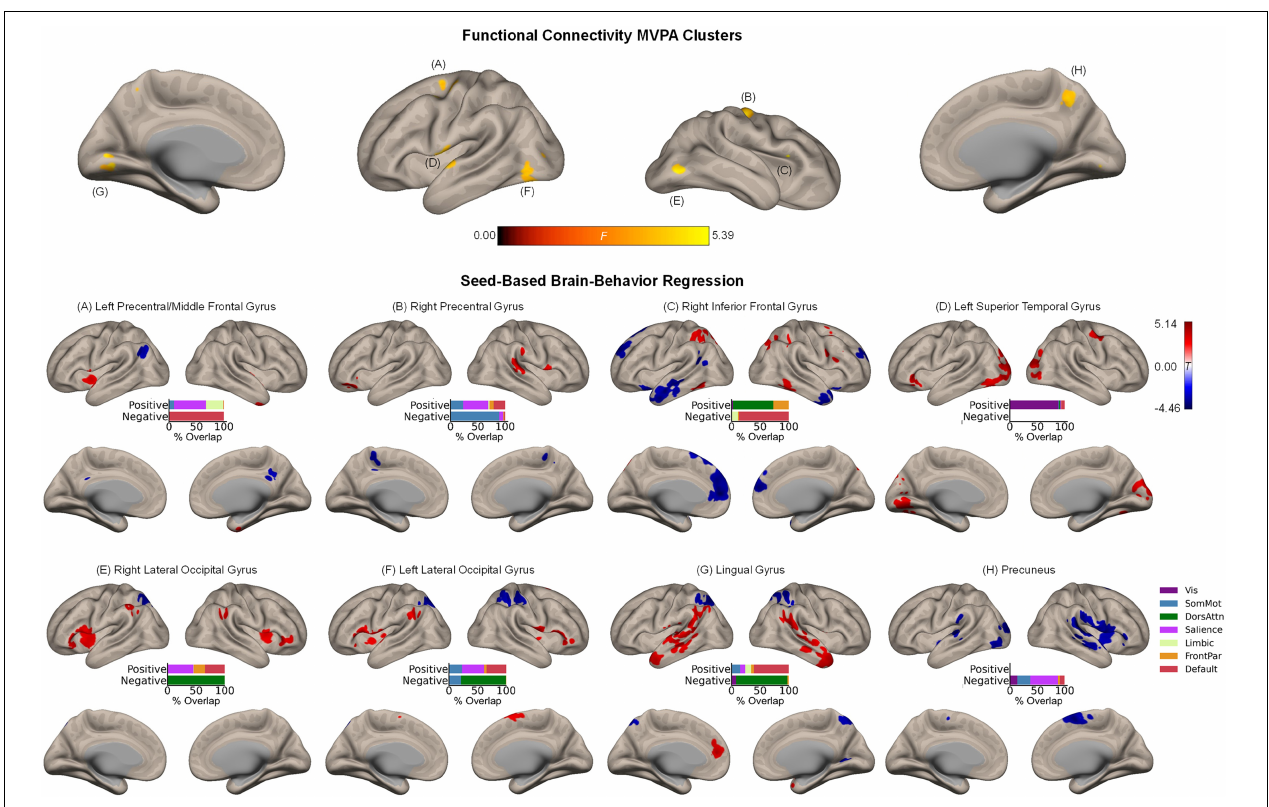
FIGURE 3 | Intrinsic functional connectivity correlates of associative memory enhancement. (Upper panel) Clusters identified in the functional connectivity MVPA as being significantly associated with associative memory enhancement. (Lower panels) Whole-brain correlation maps between seed connectivity and associative memory enhancement. Bar graphs show the percentage of overlap between the areas identified in the correlation maps and canonical functional networks of the cerebral cortex (Yeo et al., 2011). Note that the voxel-wise intensity threshold for the correlation maps corresponds to | t | = 3.12 ( p ≤